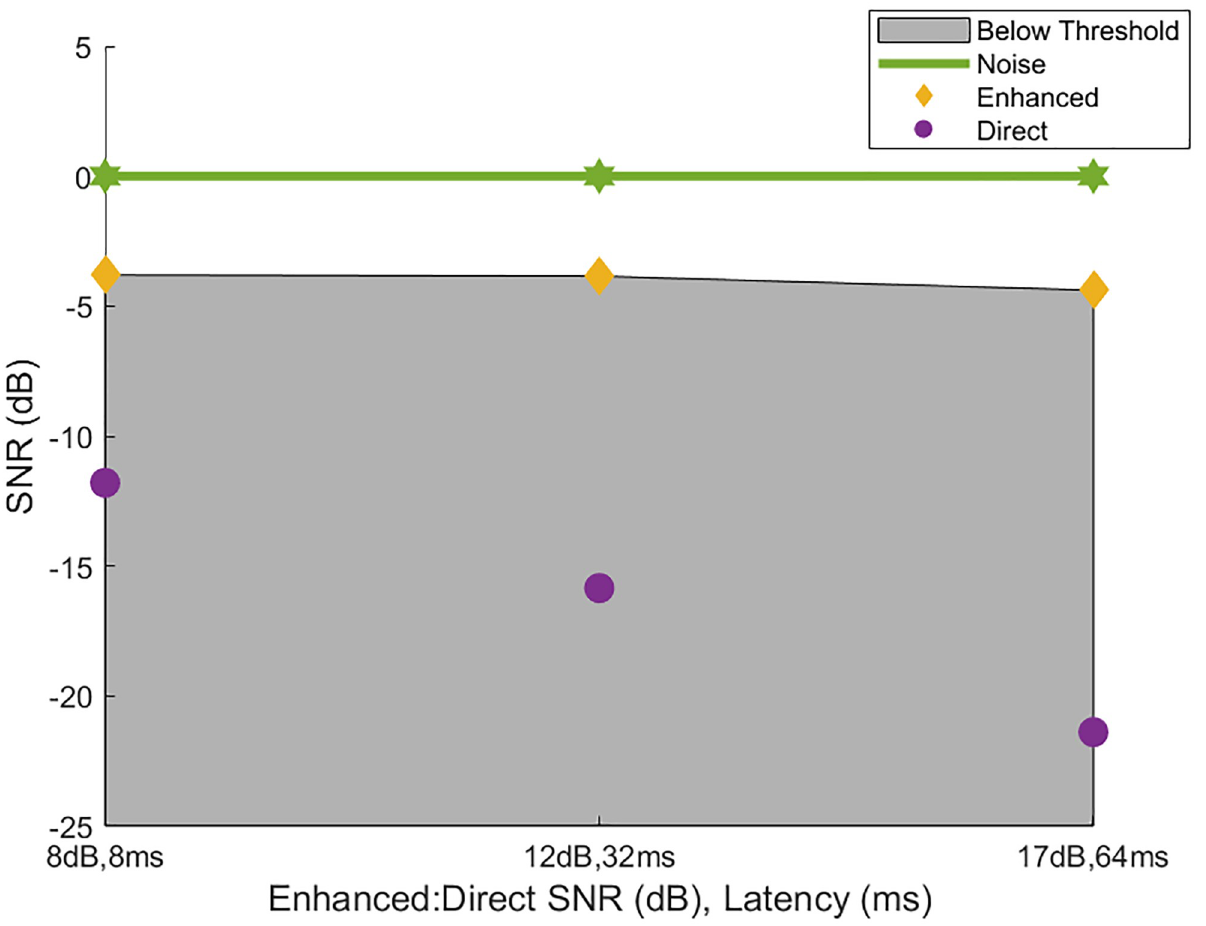
Fig 7. Signal SNR across conditions. Green line is noise level across conditions. Gray region shows the levels below the measured speech intelligibility threshold by the average listener. Yellow diamonds represent the threshold levels across conditions for the average listener. Purple circles indicate level of direct signal, unintelligible and in need of